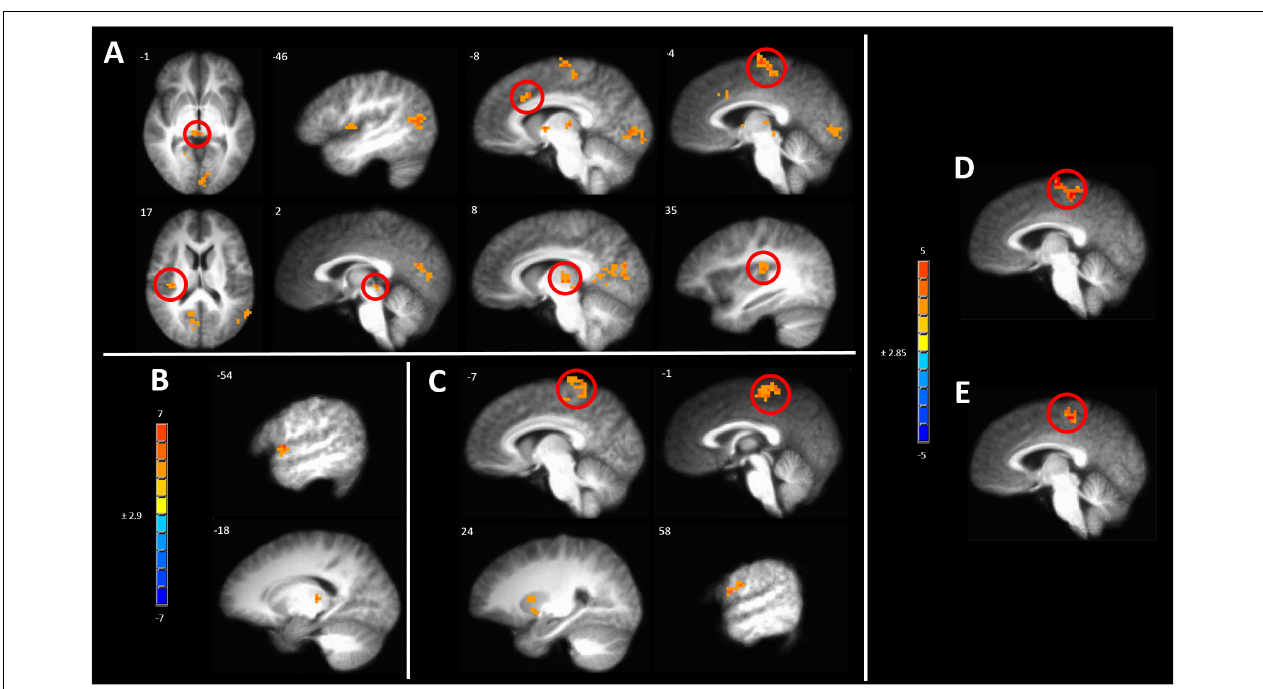
FIGURE 8 | Significant correlation of pain intensity with BOLD response evoked by painful mechanical stimuli after (A) sham, (B) anodal or (C) cathodal tDCS. (D) Conjunction analysis between the covariance maps of pain intensity with BOLD response in the pre-capsaicin condition following sham stimulation condition revealed coincident correlation in the paracentral lobule. (E) A similar analysis between the sham and cathodal stimulation conditions revealed coincident correlation only in the paracentral lobule. The resultant conjoint map of sham and anodal stimulation conditions revealed no such overlap. Maps are voxel-wise threshold of p ≤ 0.005, cluster extent corrected. Coordinates are according to the Talairach